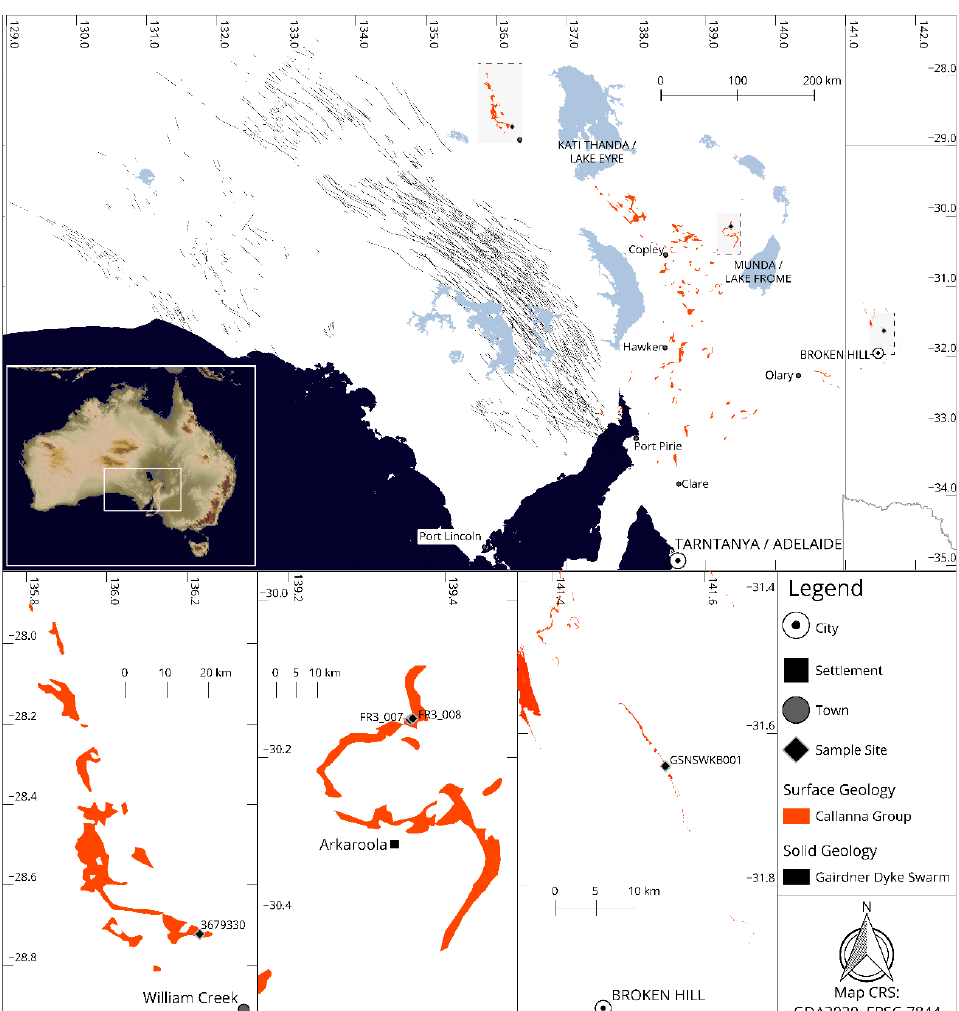
Figure 2. Distribution of the exposed Callanna Group rocks (orange), the subsurface distribution of the Gairdner Dolerite (black lines), and insets showing sample locations (west to east). The Callanna Group is characterised by initially siliciclastic sedimentation transition- ing to carbonate and evaporite dominated deposition, with minor, interbedded, mafic to intermediate volcanic and volcanogenic sequences. The Arkaroola Subgroup (Figure 3, Supplementary Figure S1) comprises basal siliciclastic units (e.g., Younghusband Con- glomerate, Paralana Quartzite), overlain by a (meta-)carbonate unit (e.g., Wywyana For- mation), and finally capped by mafic (meta-)igneous rocks (e.g., Wooltana Volcanics). The basal siliciclastic and middle carbonate sequences are thought to have been deposited in sag basins from the gradual subsidence of a stable craton prior to rifting [25]. Alternately,